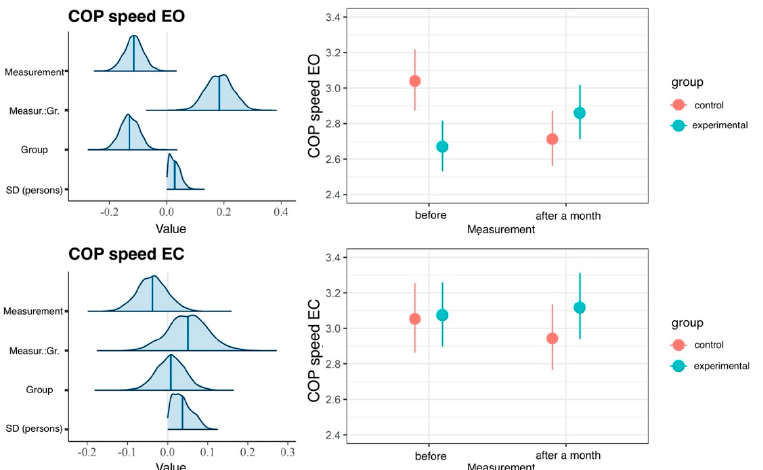
Figure 11. Results of hierarchical two-dimensional regression analysis: the dependent variable is the COP sway velocity, whereas the predictors are the dependent variable and the group. Left panels: a posteriori distributions of regression coefficients. Shaded areas denote 95% confidence level. Right panels: estimated marginal means. The points denote a posteriori distribution mean values, and vertical lines represent 95% confidence intervals. COP—center of pressure; EO—eyes open; EC – eyes closed; Measur.:Gr.—Measurement: Group.